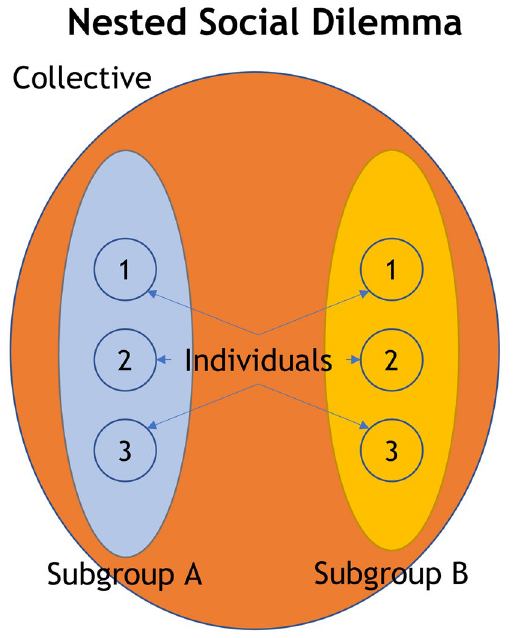
Figure 1. The structure of the Nested Social Dilemma (NSD) paradigm. Individuals (1, 2, 3) are members of one of two subgroups (Subgroup A or Subgroup B). The two subgroups are nested within a larger collective. Participants’ task is to divide an endowed resource between ‘accounts’ that would benefit themselves as individuals, their own subgroup, or the larger collective. The nature of the dilemma is that, although allocations to the subgroup and collective accounts are multiplied by a factor (2.5 and 4, respectively) before being divided between individual members, it is unclear how other participants will make their